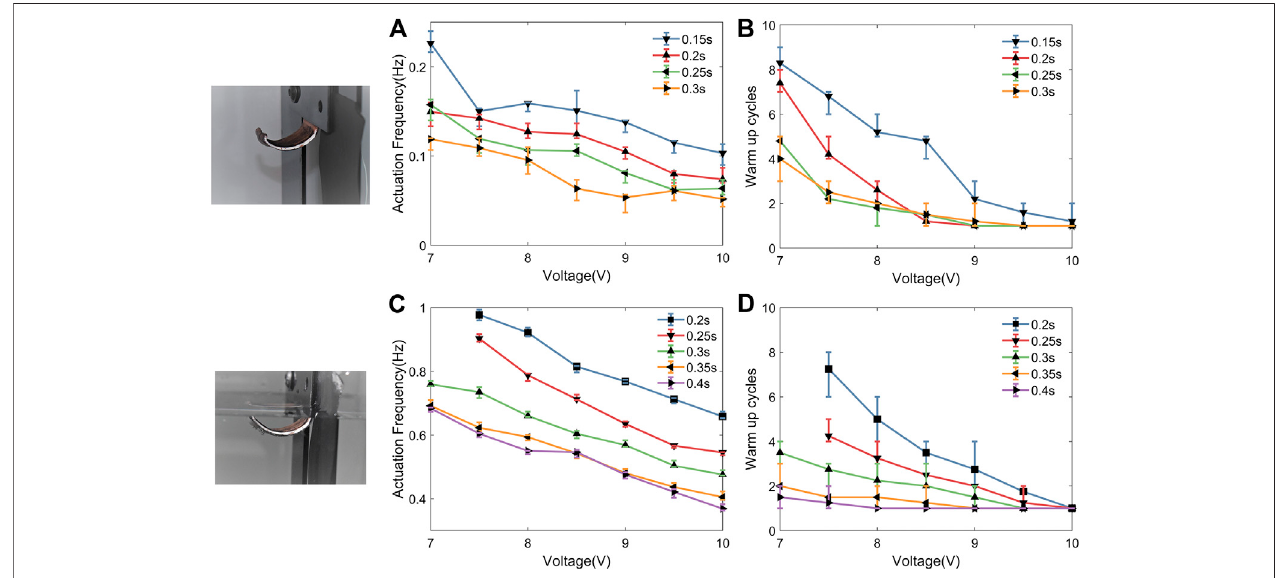
FIGURE6| Comparisonofactuationfrequencyandwarm-upcyclesvaryingactivationtimeandvoltagebothinairandwater.Normally,highbandwidthwithoneor two warm-up cycles is optimal for actuator application.